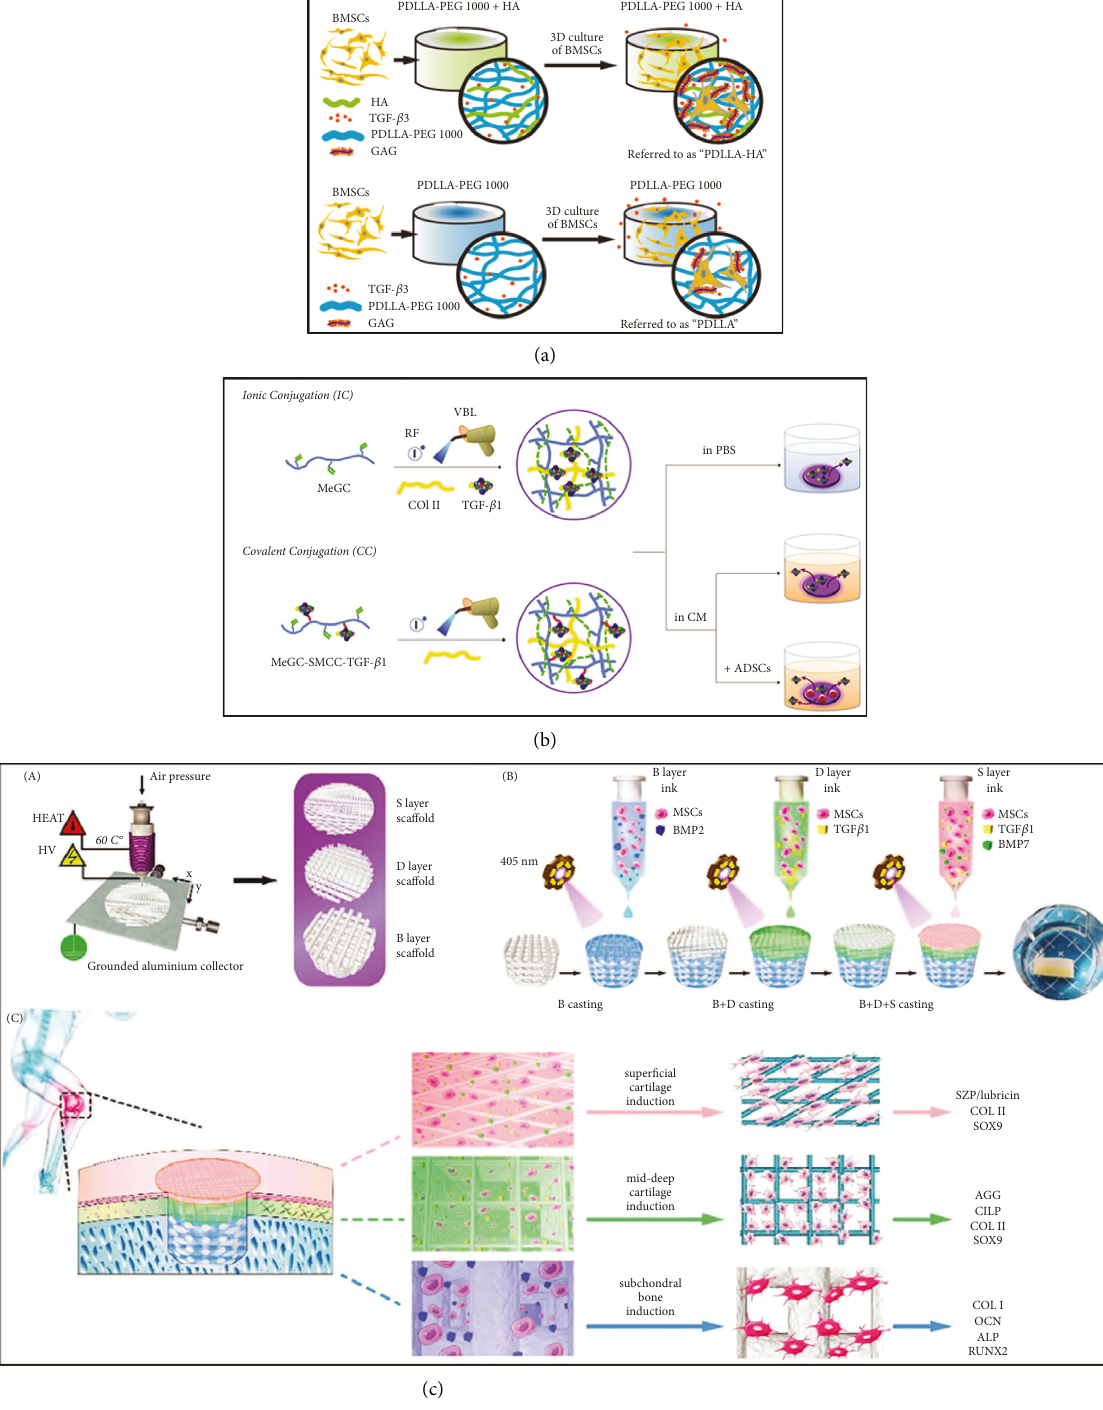
Figure 2: Various hydrogel-based growth factor delivery systems for cartilage regeneration. (a) Depiction of fabrication and culture of cell- loaded constructs. (A) represents the PDLLA/HA group, and (B) represents the PDLLA group; (b) schematic of TGF- β 1 delivery from blue light-reactive MeGC hydrogels prepared by ionic conjugation or conjugation; (c) schematic diagram of the preparation and application of the trilayered fiber-reinforced and growth factor-loaded hydrogel construct: (A) fiber networks for the SD and B layers were fabricated by melt electrowriting; (B) the composite was constructed using the UV-assisted, stepwise infiltration, and crosslinking procedures; and (C) schematic illustration for the application of the trilayered composite scaffold in layer-specific osteochondral tissue induction and re- generation. Adapted with permission from Deng et al. [42], Choi et al. [95], and Qiao et al.